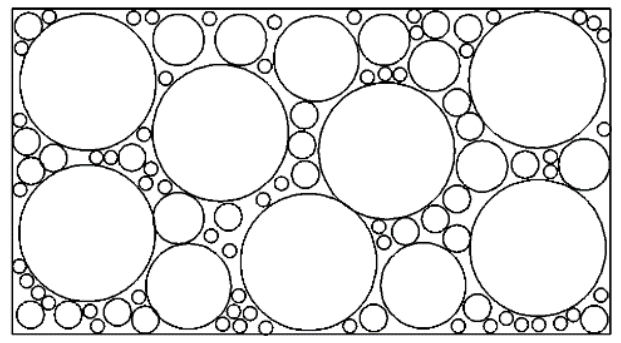
Figure 3. Pattern of accumulation of powder particles.